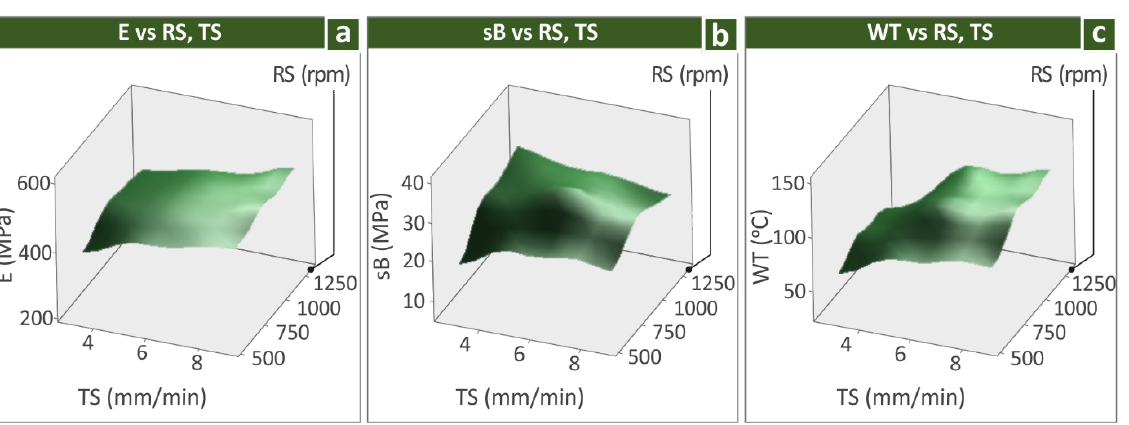
where Y k is the output ( Y 1 , Y 2 , Y 3 : E/MPa, sB/MPa, and WT/ ◦ C), b is the constant